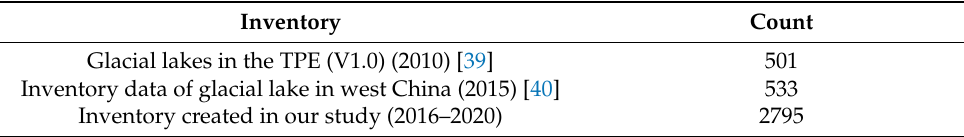
Table 8. Three inventories of glacial lakes in different periods.